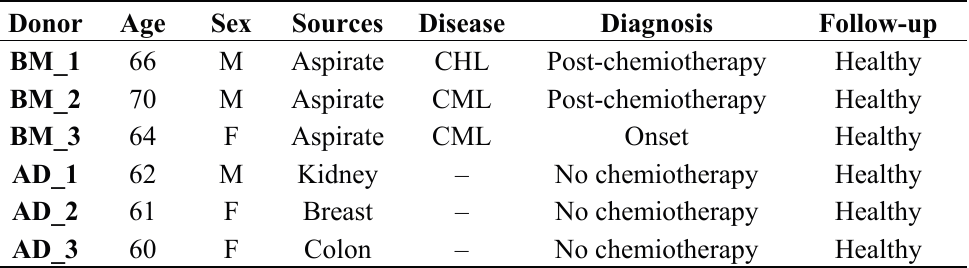
Table 2. Table summarizing the cell origin and the clinical data of donor